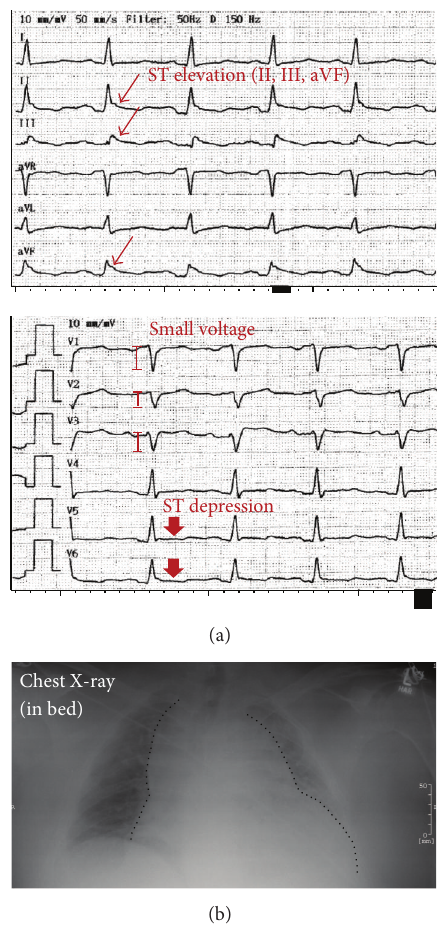
Figure 1: ECG and chest X-ray of the patient. (a) ECG showing ST elevations and low voltage QRS complexes as indirect signs of acute pericardial effusion. (b) Chest X-ray shows cardiomegaly with central and peripheral pulmonary venous congestion. Heart silhouette is highlighted by a dotted black